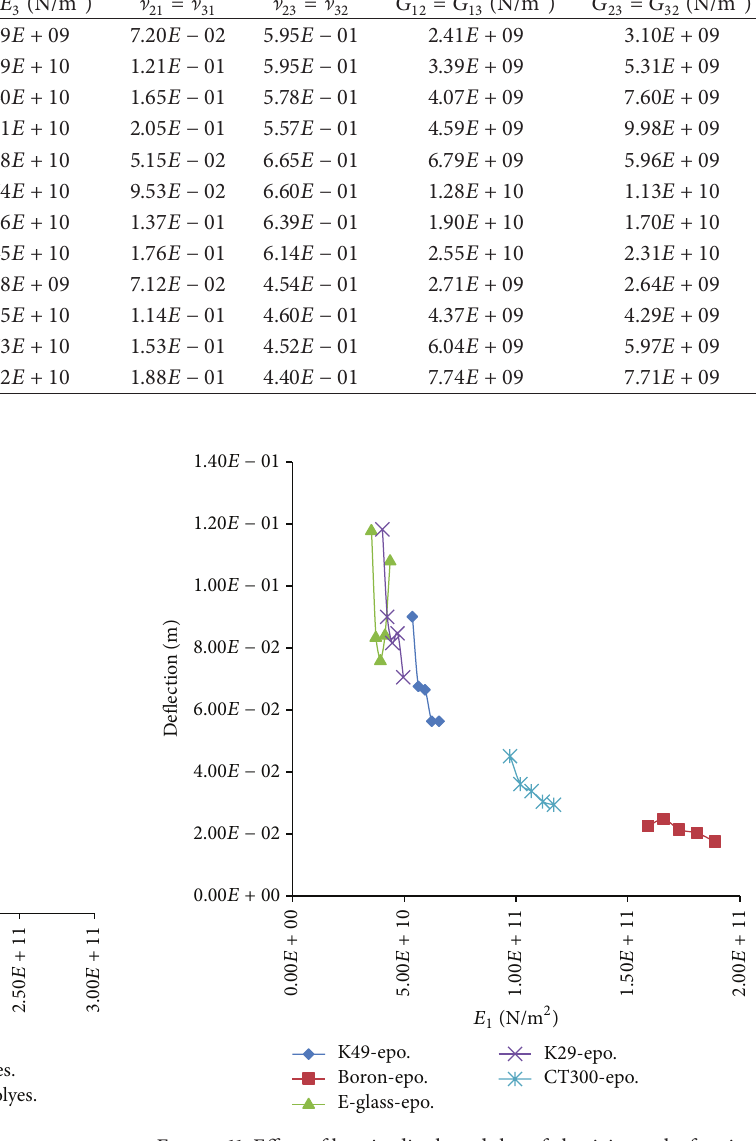
Figure 10: Effect of longitudinal modulus of elasticity on leaf spring deflection of various composite leaf springs based on matrix type.